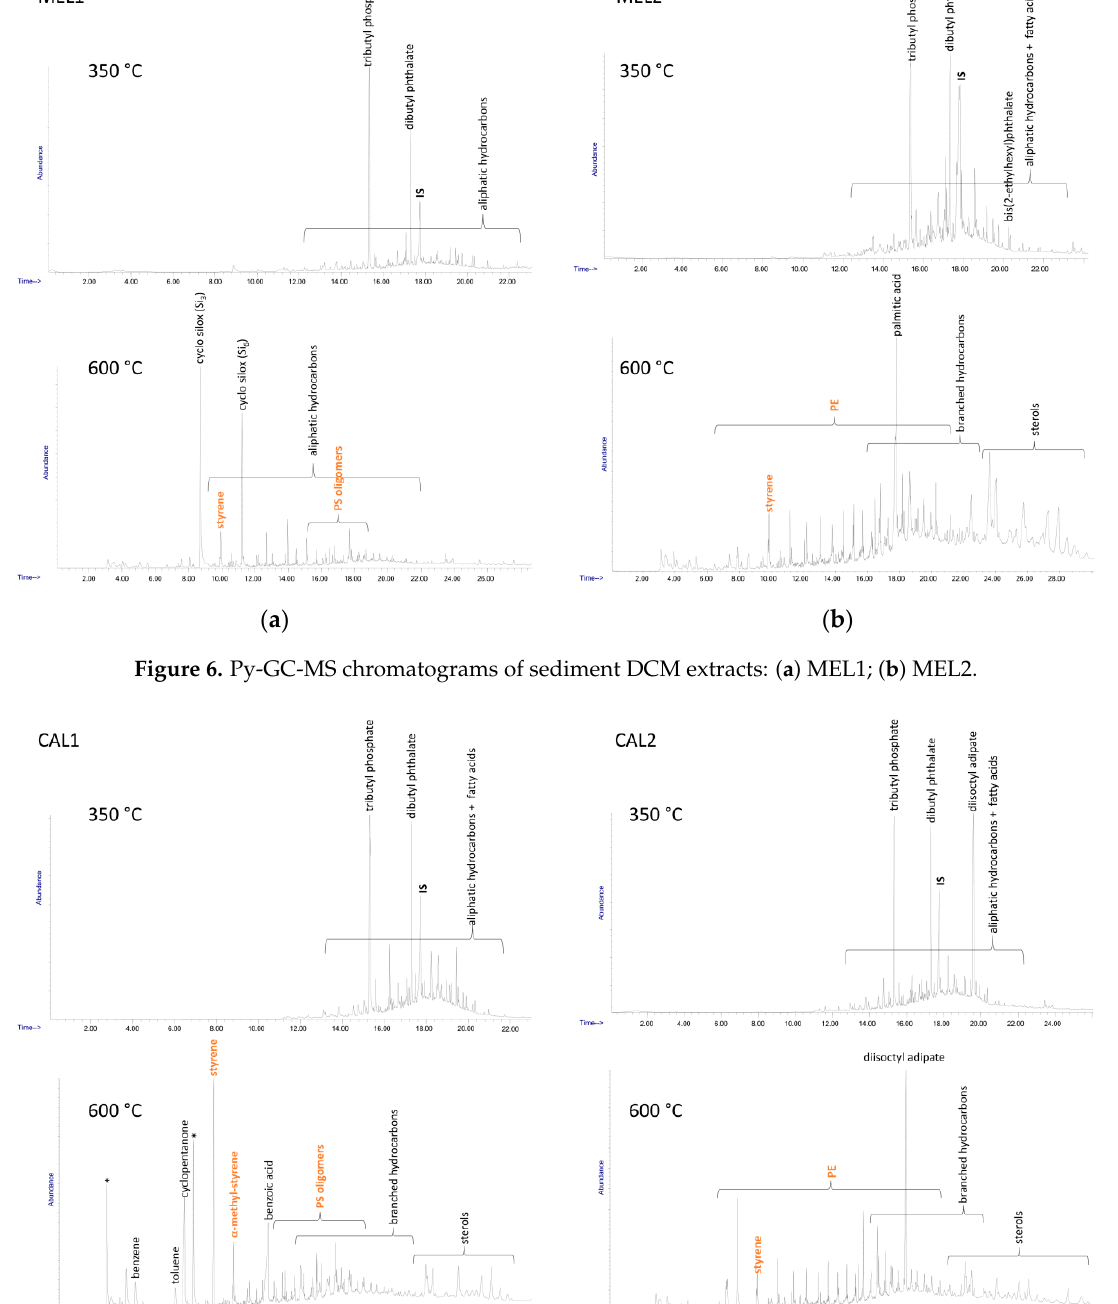
refluxing xylene. After distilling off most of the xylene from the final extracts they were added with an excess of a solution of KOH in methanol and the precipitate was then collected by filtration, dried, and weighed. A quantifiable number of precipitated